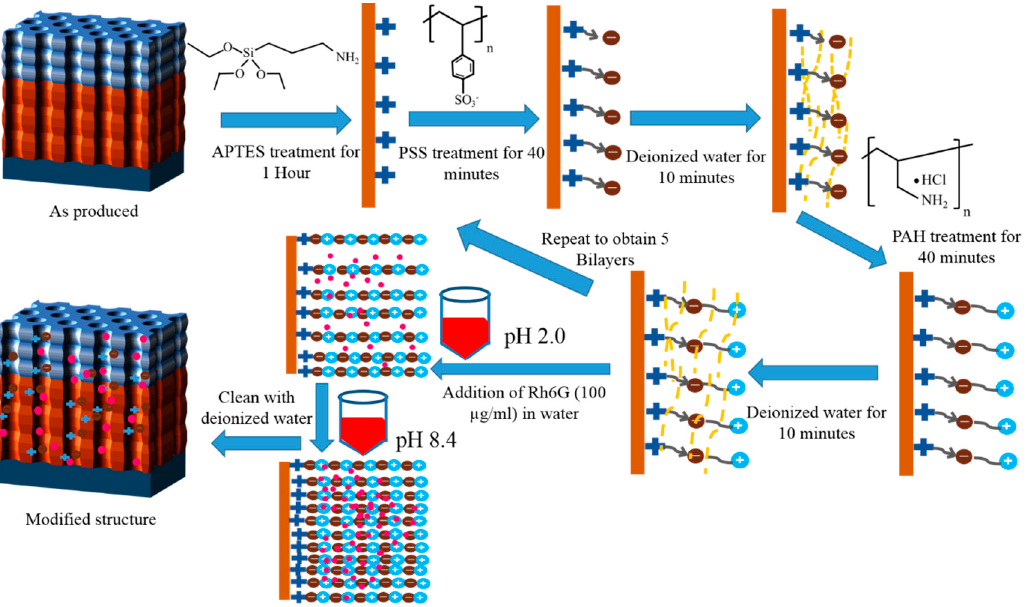
Figure 2. Schematic illustration of polyelectrolyte layer by layer deposition and cargo molecule